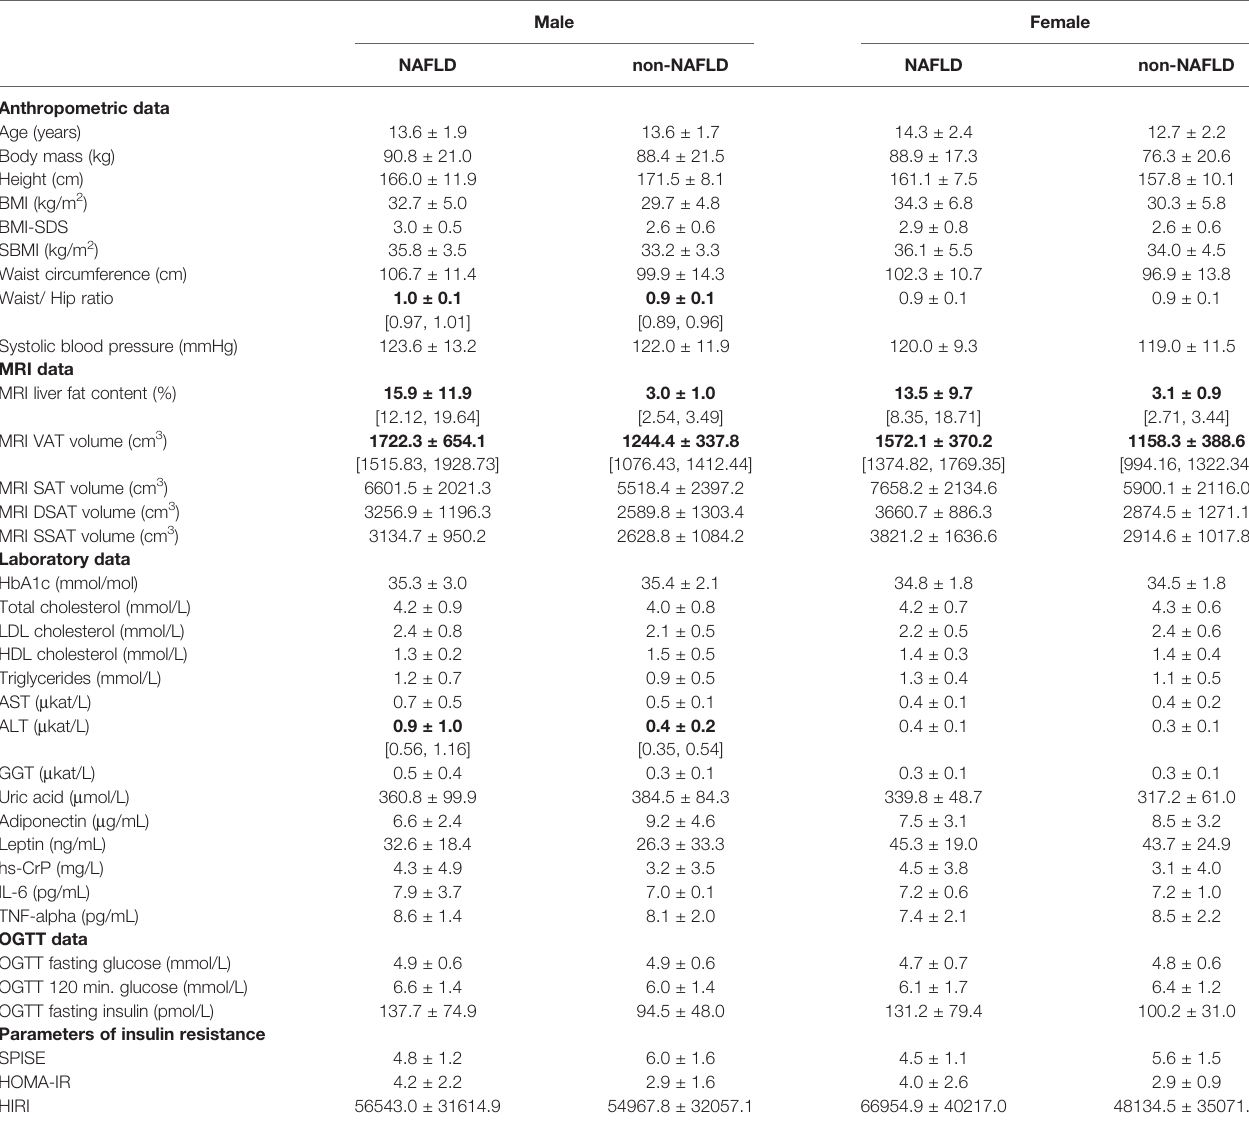
TABLE 2 | Descriptive data of NAFLD (male n = 41 § , female n = 16 + ) and non-NAFLD patients (male n = 18 # , female n = 24 $ ). NAFLD was de fi ned as liver fat content > 5% according to